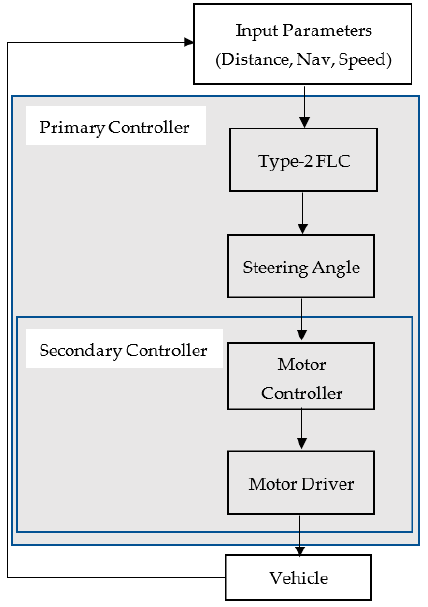
Figure 3. Block diagram system .